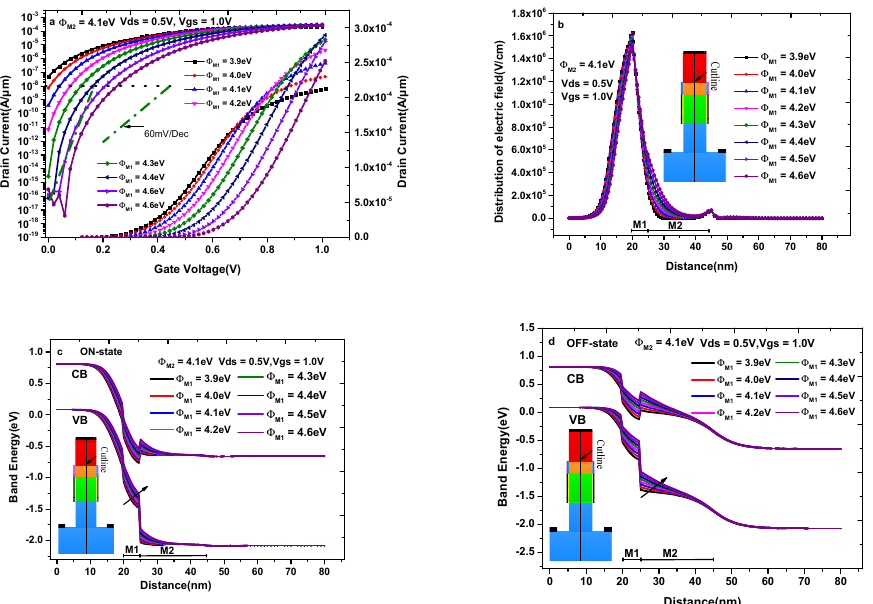
Figure 9. ( a ) Transfer characteristics of DMG-HD-VTFET with different Φ M1 ; ( b ) the distribution of electric field with different Φ M1 ; ( c ) the ON-state energy band diagram with different Φ M1 ; ( d ) the OFF-state energy band diagram with different Φ M1 .